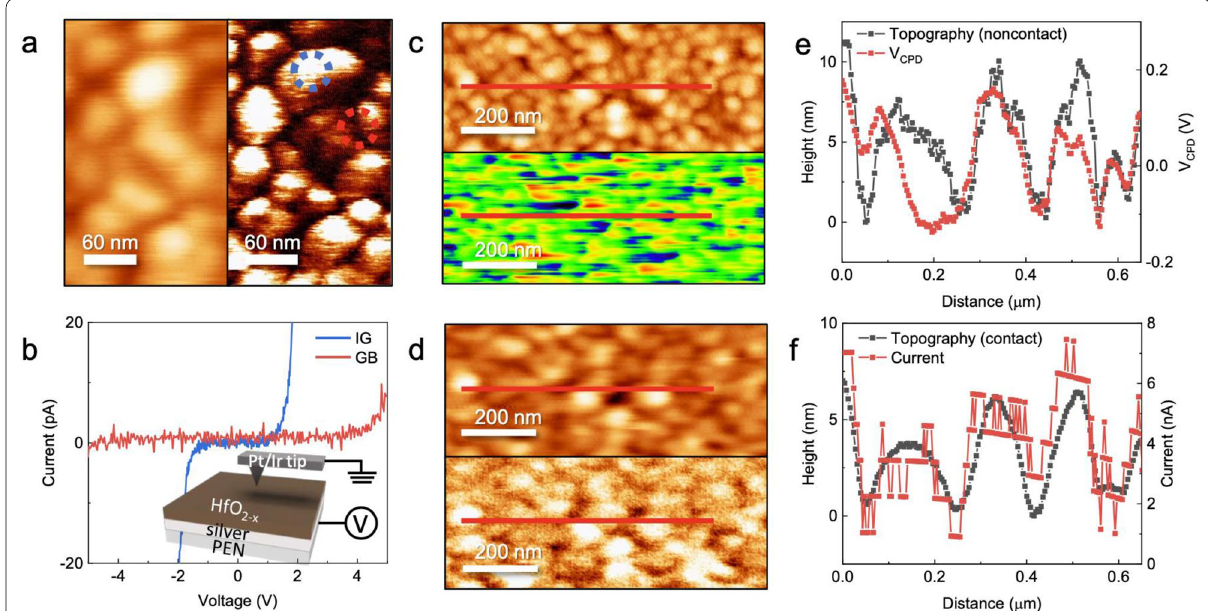
Fig. 4 CPD and current mapping corresponding topography for a HfO 2- x thin film. a Simultaneously obtained topography (left) and current mapping images (right) for the conducting states. The blue and red dotted circles represent intergrain and grain boundaries, respectively. b Local I-V data for the intergrain (blue) and grain boundaries (red). The inset shows a schematic of the cAFM setup used for characterizing HfO 2- x thin films. c Topography (top) and CPD mapping image (bottom) and d topography (top) and current mapping image (bottom) at the same position for the conducting states. Line profiles of e topography and CPD mapping images and f topography and current mapping images along the red lines in ( c ) and ( d